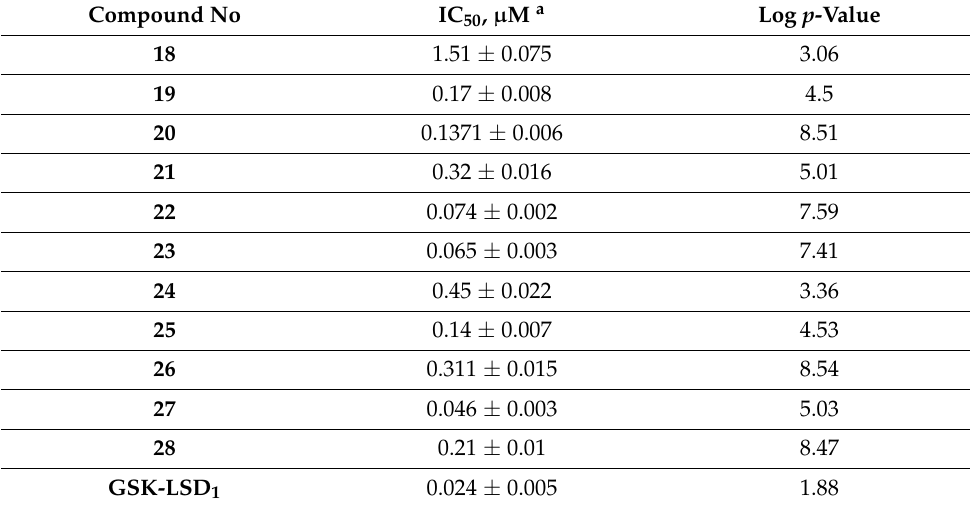
Table 2. LSD 1 Inhibitory data of target compounds 18 – 28 .